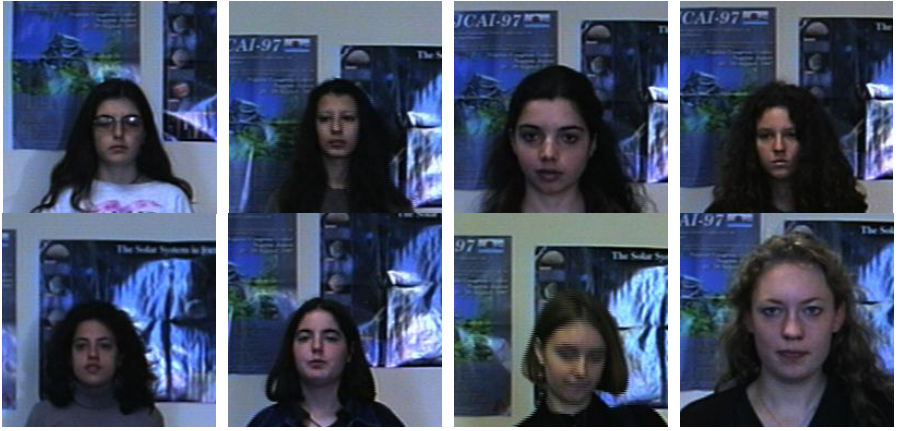
Figure 8. Several typical faces in the